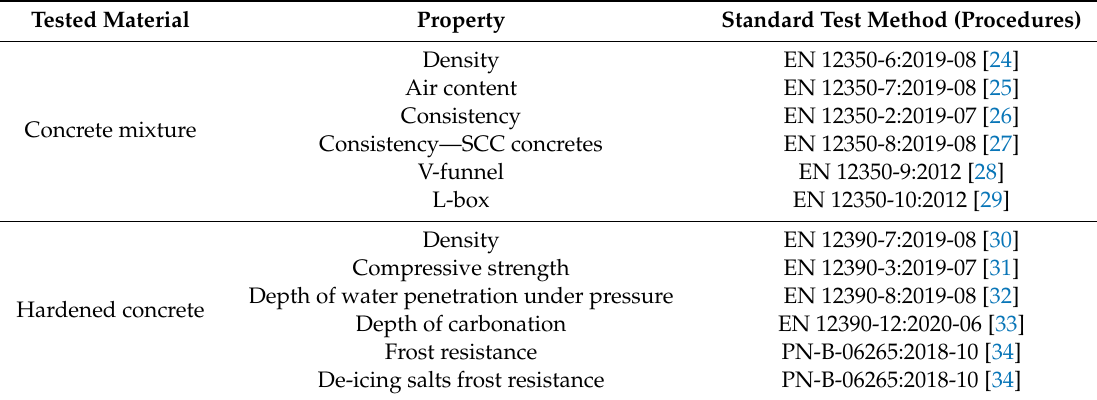
Table 4. Research methods used to determine the